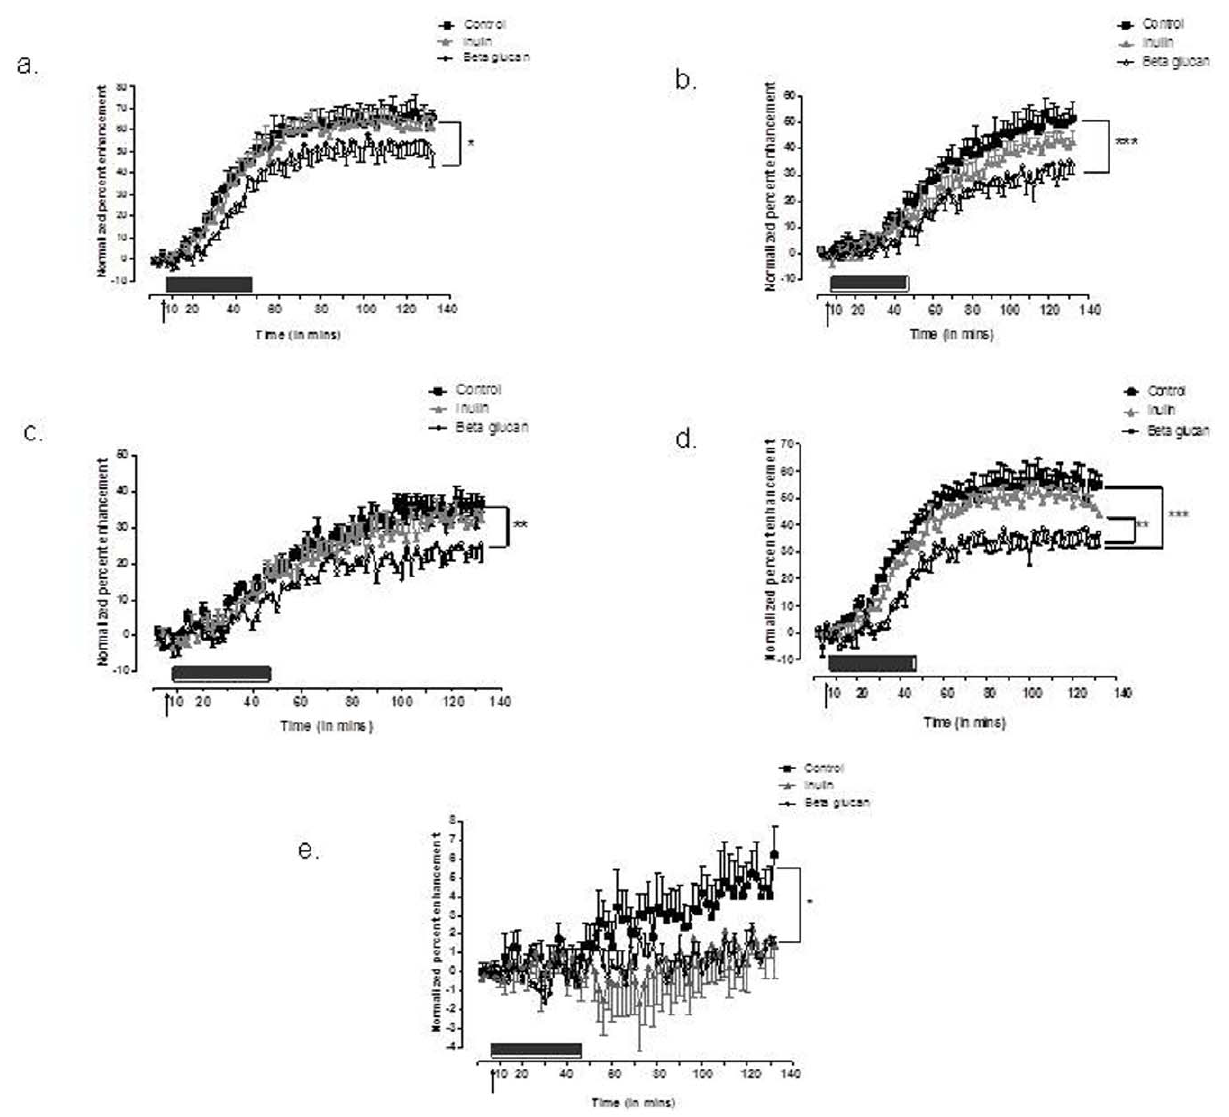
Figure 4. Representative baseline (pre-contrast) MRI images of the mouse brain showing assignment of regions of interest (ROIs) in various brain areas from which signal intensities (SI) were obtained. Time course of changes in SI (as a percentage of baseline) before and at various times after IV manganese chloride infusion in the (a) ARC, (b) VMH (c) PVN (d) PE (e) NTS. Data are presented as means of four consecutive image acquisitions 6 SEM. *=p , 0.05, **=p , 0.01, ***=p , 0.001 Key: ARC, arcuate nucleus; VMH, ventromedial hypothalamic nucleus; PVN, paraventricular hypothalamic nucleus; PE, periventricular nucleus; NTS, nucleus of solitaries tractus; HFD-C, high fat diet control; HFD-I, high fat diet + inulin; HFD-BG, high fat diet + b